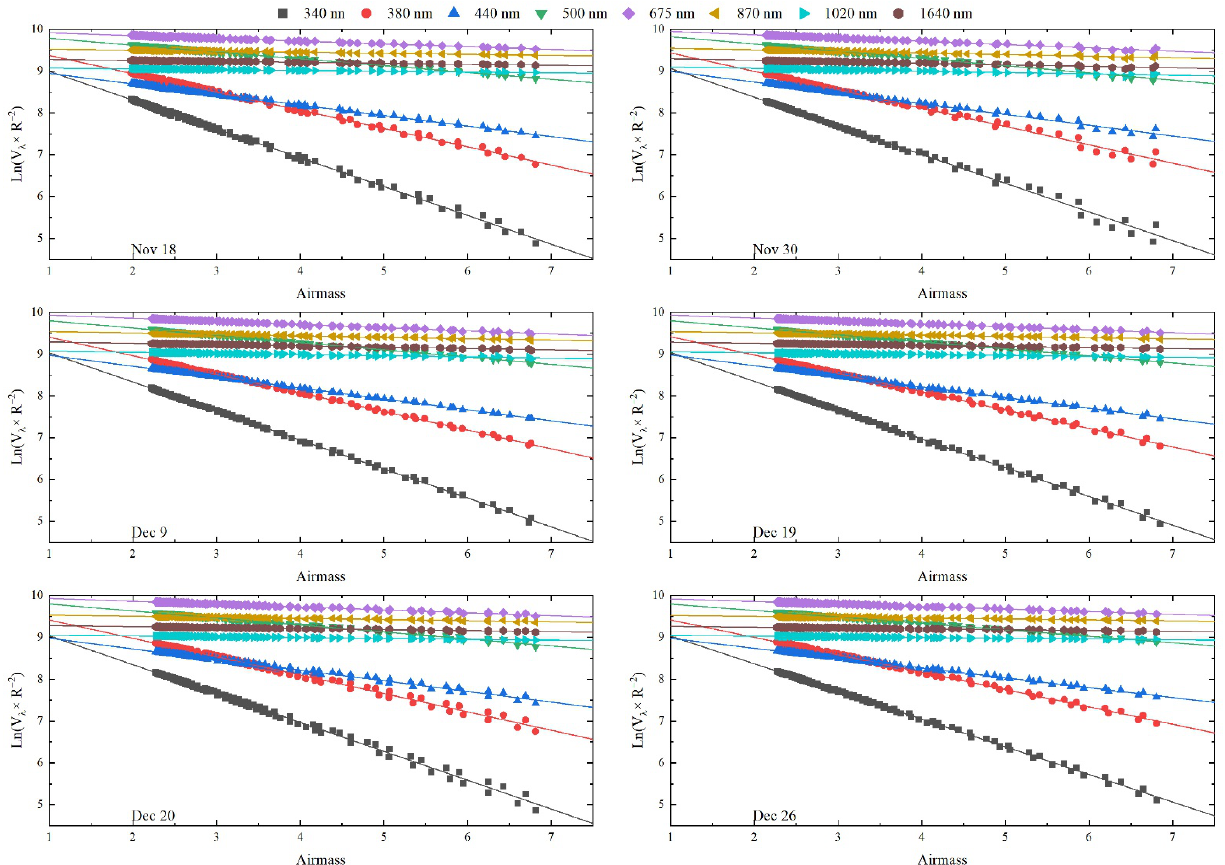
Figure 6. Langley plots for the six study days during daytime observations. Previous studies have suggested that this may be a result of the influence of aerosol loading and the irradiance regime [46,49,65,66]. Local convection rises from the upper boundary layer to the observational level in the afternoon at both inland sites—such as Mt Waliguan (36.28° N, 100.09° E, and 3826 m a.s.l.; China), the Jungfraujoch (46.51° N, 7.96° E, and 3580 m a.s.l.; Switzerland) and the Sierra Nevada (37.1° N, 3.4° W, and 2100